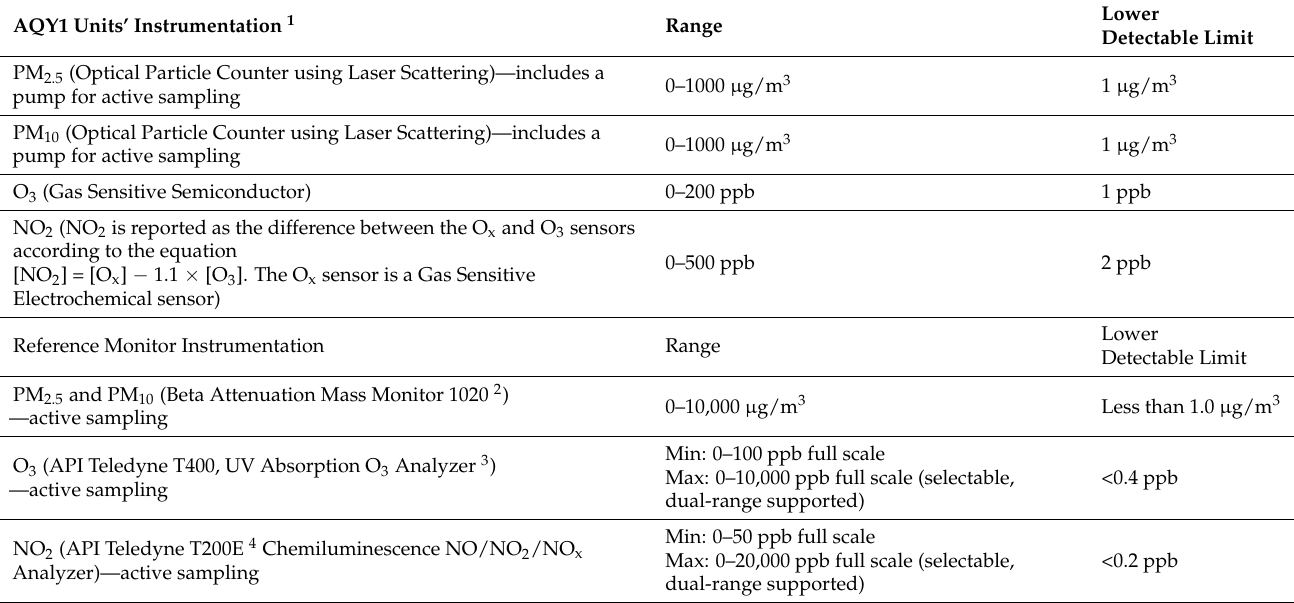
Table 1. AQY1 and reference monitor instrumentation, pollutant ranges, and lower detectable